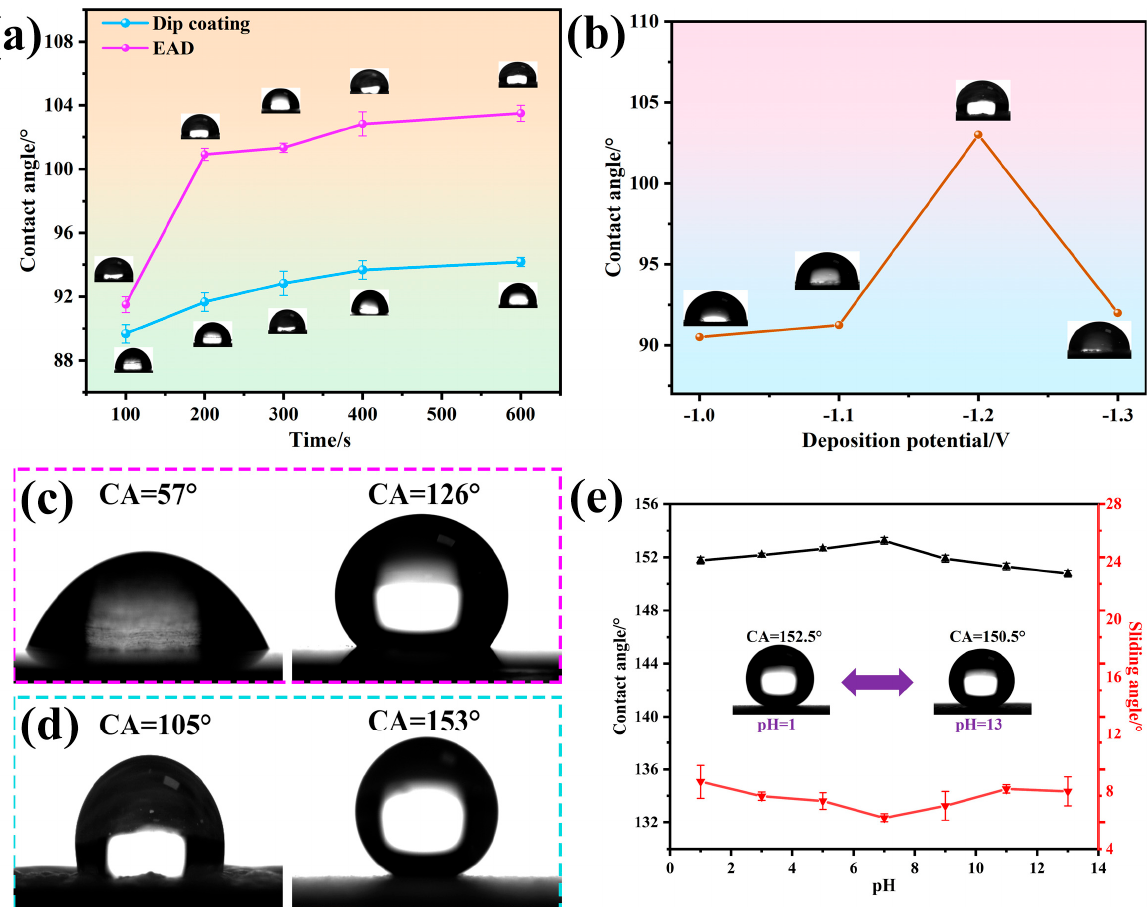
Figure 11. ( a ) Contact angles (CA) of coatings prepared by the EAD method (at − 1.2 V vs.